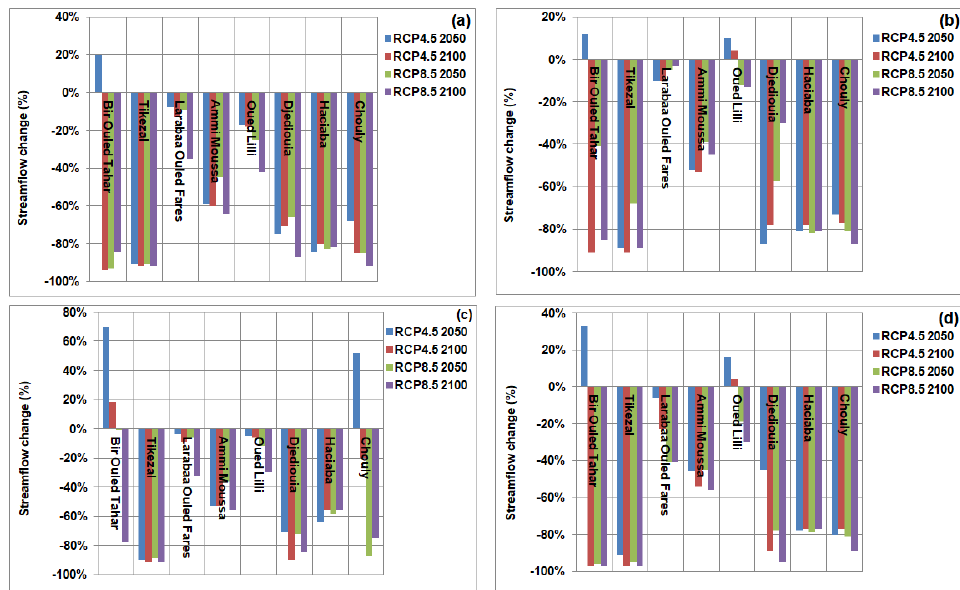
Figure 8. Changes in autumn streamflow relative to the historical period under two scenarios (RCP4.5 and RCP8.5): ( a ) quantile mapping, ( b ) scaled distribution mapping, ( c ) quantile delta mapping, and ( d ) model RAW.